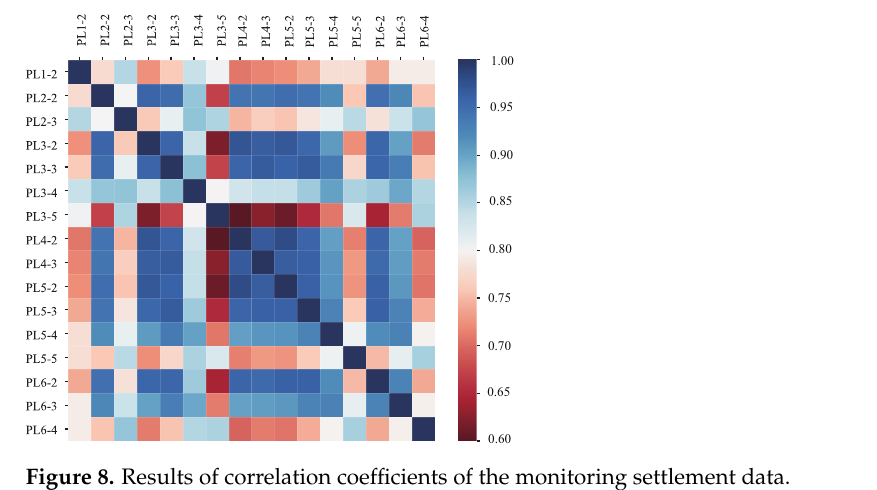
Figure 8. Results of correlation coefficients of the monitoring settlement data.